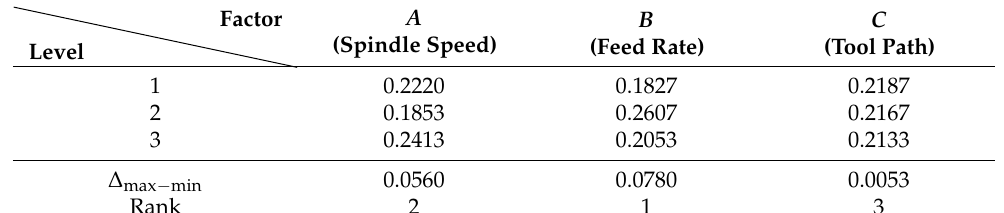
Table 16. Response table for means for surface roughness.